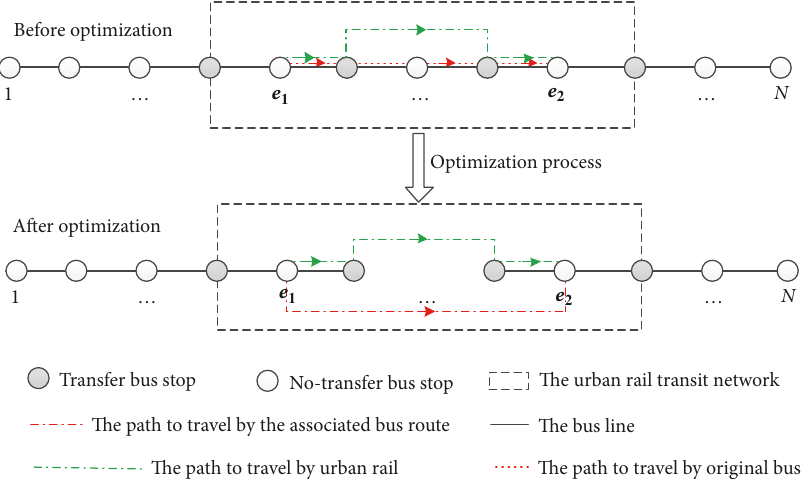
Figure 2: An example of passengers choosing the associated bus